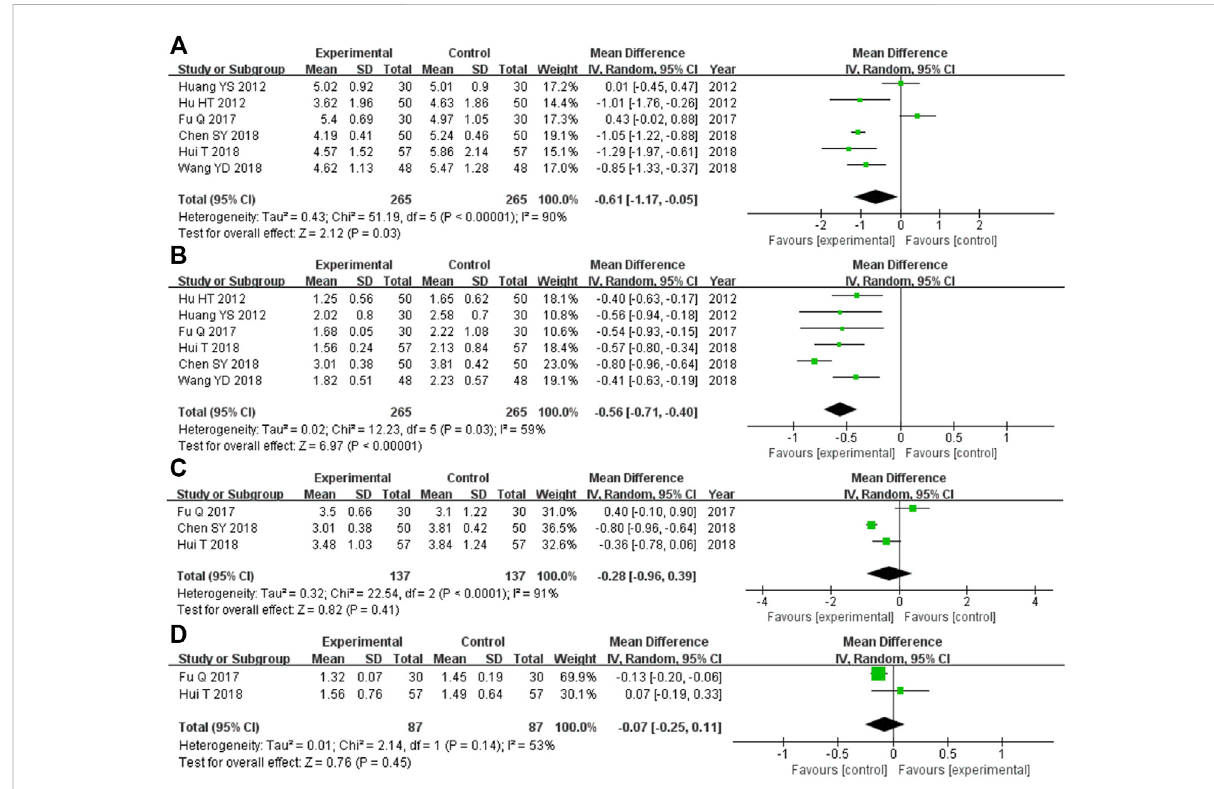
FIGURE 5 Comparativeforestplot:bloodlipidindices. (A) ThepooledMDwas − 0.61(95%CI − 1.17to − 0.05, p =0.03).TClevelsintheexperimentalcohort were signi fi cantly lower than those in the control cohort. (B) The pooled MD was − 0.56 (95% CI − 0.71 to − 0.40, p < 0.00001). TG levels in the experimental cohort were signi fi cantly lower than those in the control cohort. (C) The pooled MD was − 0.28 (95% CI − 0.96 to 0.39, p = 0.41). There was no signi fi cant difference in the LDL-C level between the experimental and control cohorts. (D) The pooled MD was − 0.07 (95% CI − 0.25 to 0.11, p = 0.45). There was no signi fi cant difference in HDL-C levels between the experimental and control cohorts. MD, mean difference; CI, con fi denceinterval; TC, totalcholesterol; TG, triglyceride;LDL-C, low-densitylipoproteincholesterol; HDL-C, high-density lipoprotein